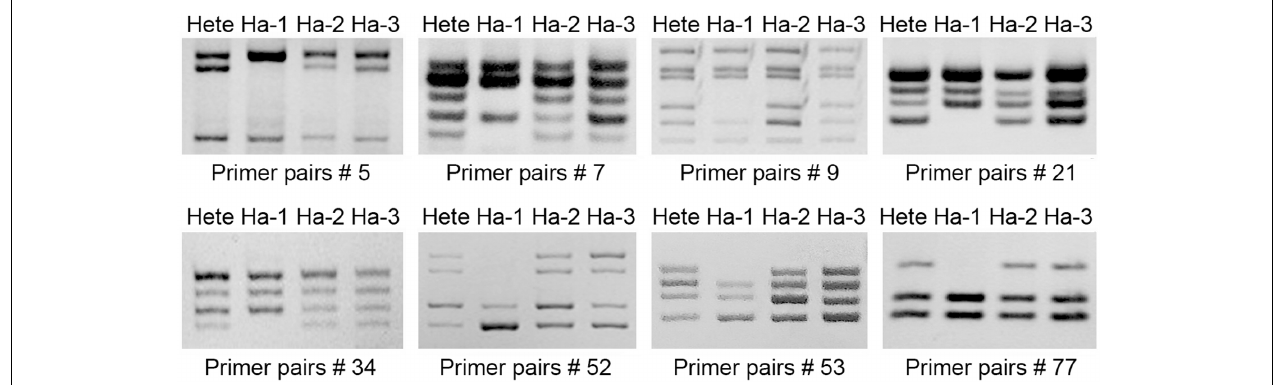
FIGURE 3 | Microsatellite fingerprinting reveals the genomic constitution of the regenerants from ovule culture. Hete is cv. “Zhongshanzigui,” Ha-1 is a true haploid; Ha-2 and Ha-3 originate from somatic maternal tissue.